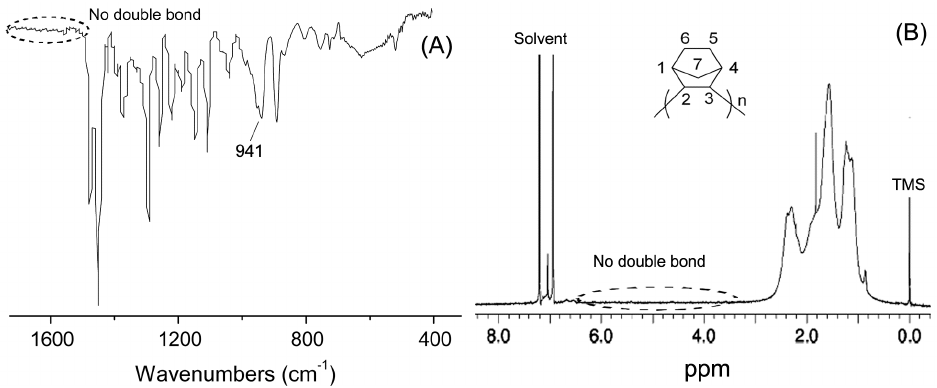
Figure 3. IR ( A ) and 1 H NMR ( B ) spectroscopy of the polynorbornene (TMS: tetramethylsilane).